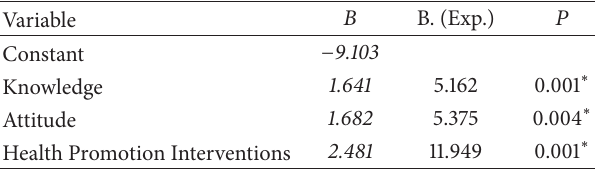
Table 4: Multiple log regression models of interventions against the behavior of quitting smoking.